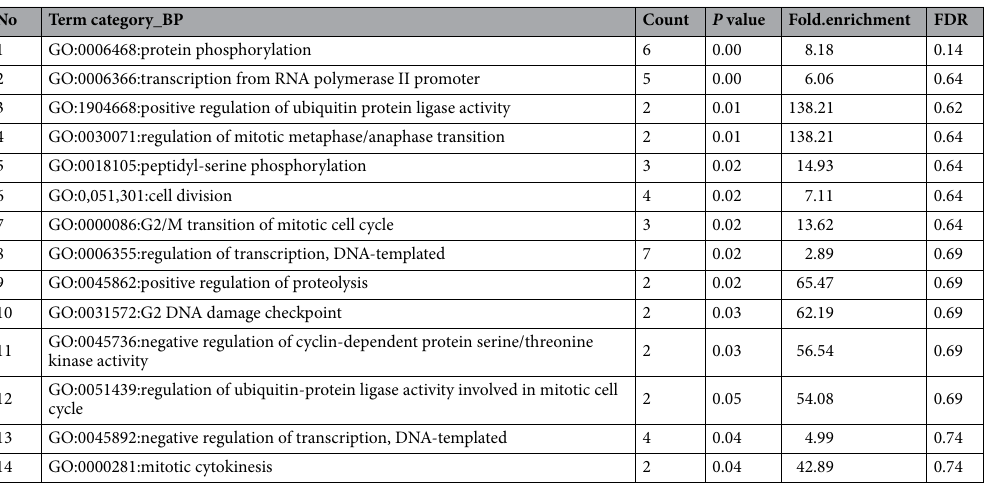
Table 3. Functional annotation of GO_BP for candidate